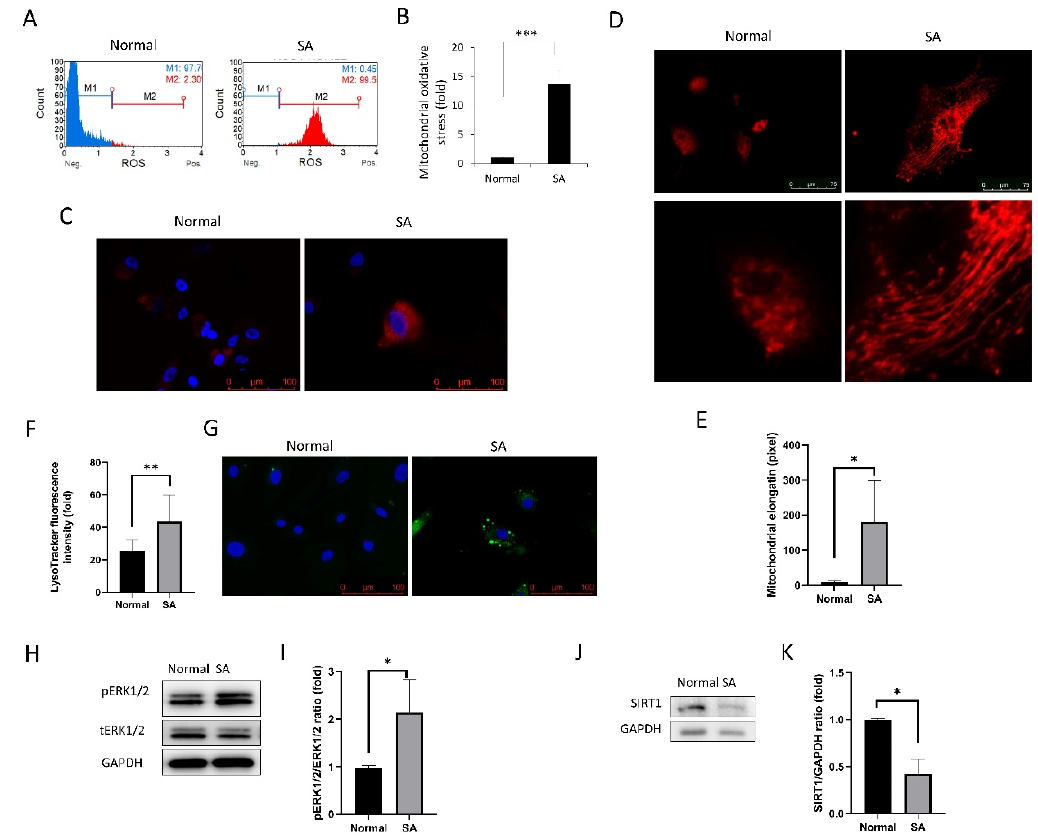
Figure 2. Mitochondrial oxidative stress, elongation, and lysosome staining. ( A ) MitoSOX staining intensity of cells as analyzed using the Muse cell analyzer. ( B ) Mitochondrial oxidative stress levels were compared between the normal and SA groups. ( C ) Fluorescence imaging using the MitoSOX probe shows mitochondrial oxidative stress in cells. ( D ) MitoTracker red was used for mitochondrial imaging of cells from normal and SA groups. Mitochondrial elongation is shown in the SA group. ( E ) Mitochondrial elongation is greater in the SA group as compared to that in the normal group. ( F , G ) Lysosomal staining of cells from the normal and SA groups. ( H , I ) phospho- extracellular signal-regulated protein kinases 1 and 2 (pERK1 / 2) expression levels are shown. ( J , K ) SIRT1 expression levels are shown. All experiments were performed in triplicate or quadruplicate. * for p < 0.05 using independent t -test.